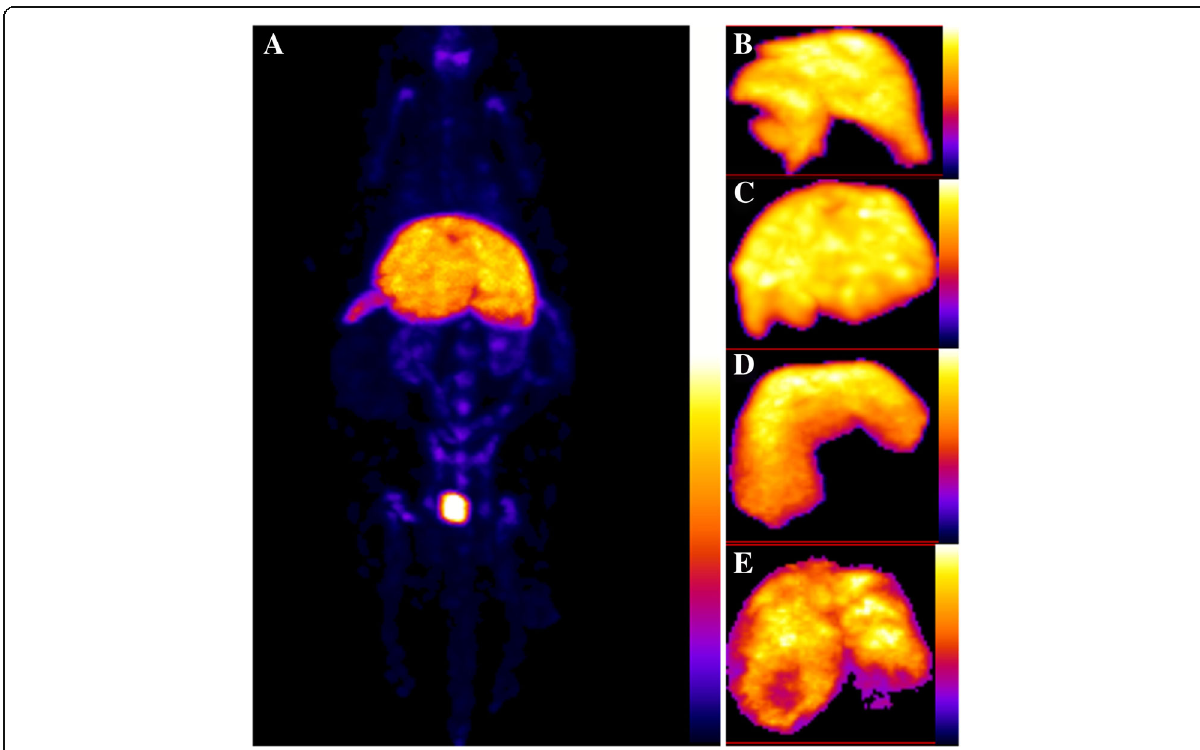
Fig. 1 a The result of 99m Tc-protein nanoparticle whole-body SPECT scan. b – e Selected projections of the segmented liver in control, obese, metastatic, and primary tumor groups respectively from top to bottom (additional projections are available in the supplementary material; all images are from individual